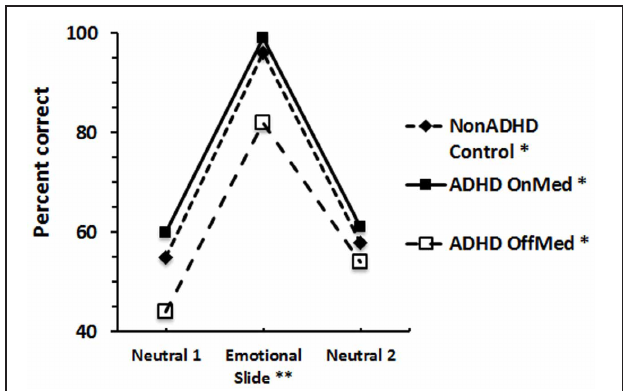
FIGURE 1 | Story recall of control and ADHD adults. Average score of each group in each story phase. ∗ Significant difference within each group across the 3 story phases; ∗∗ Significant difference among the 3 groups on the Emotional Slide